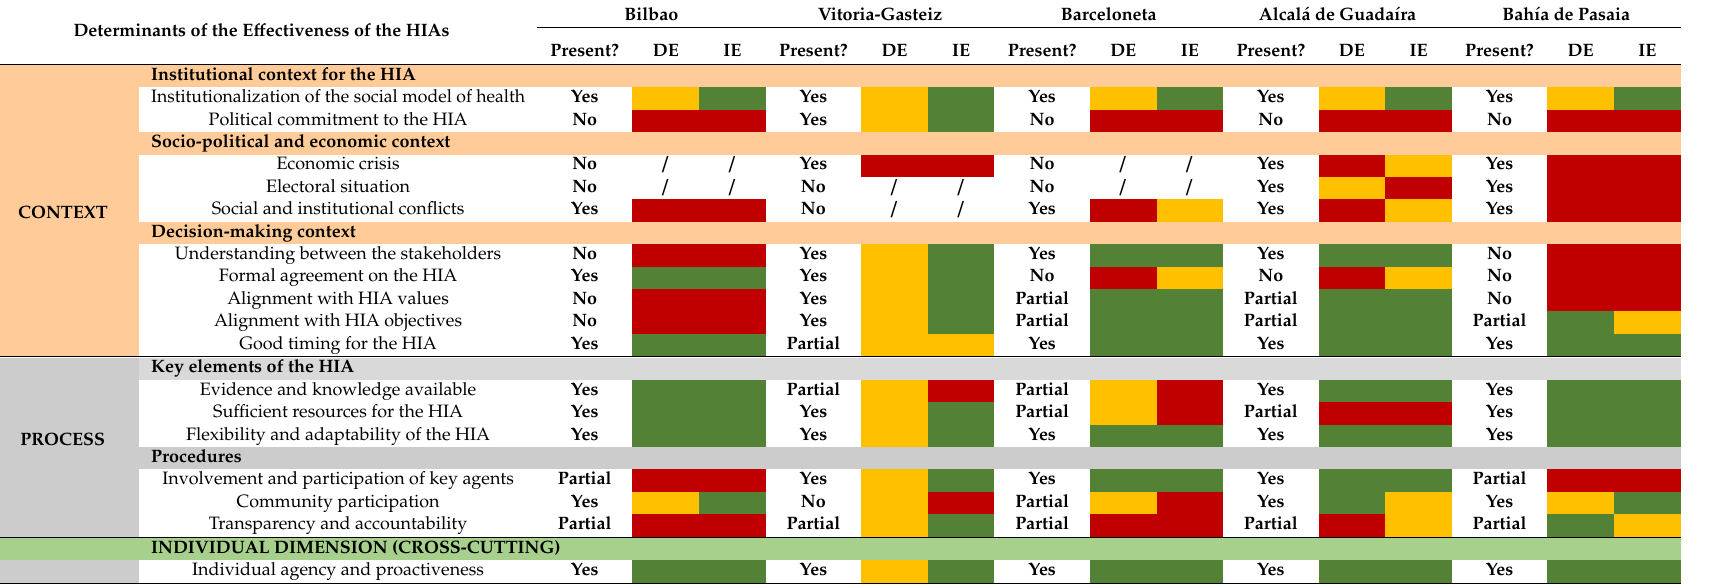
Table 5. Determinants of the e ff ectiveness of the